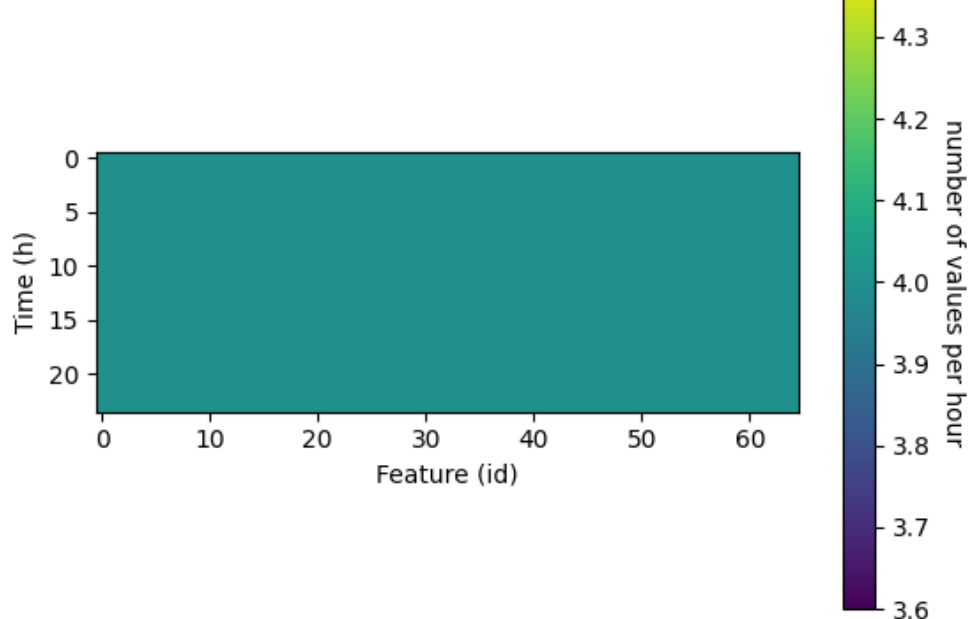
Figure 11. Result after the use of smart join. After the joining, all features have a common sampling distribution.